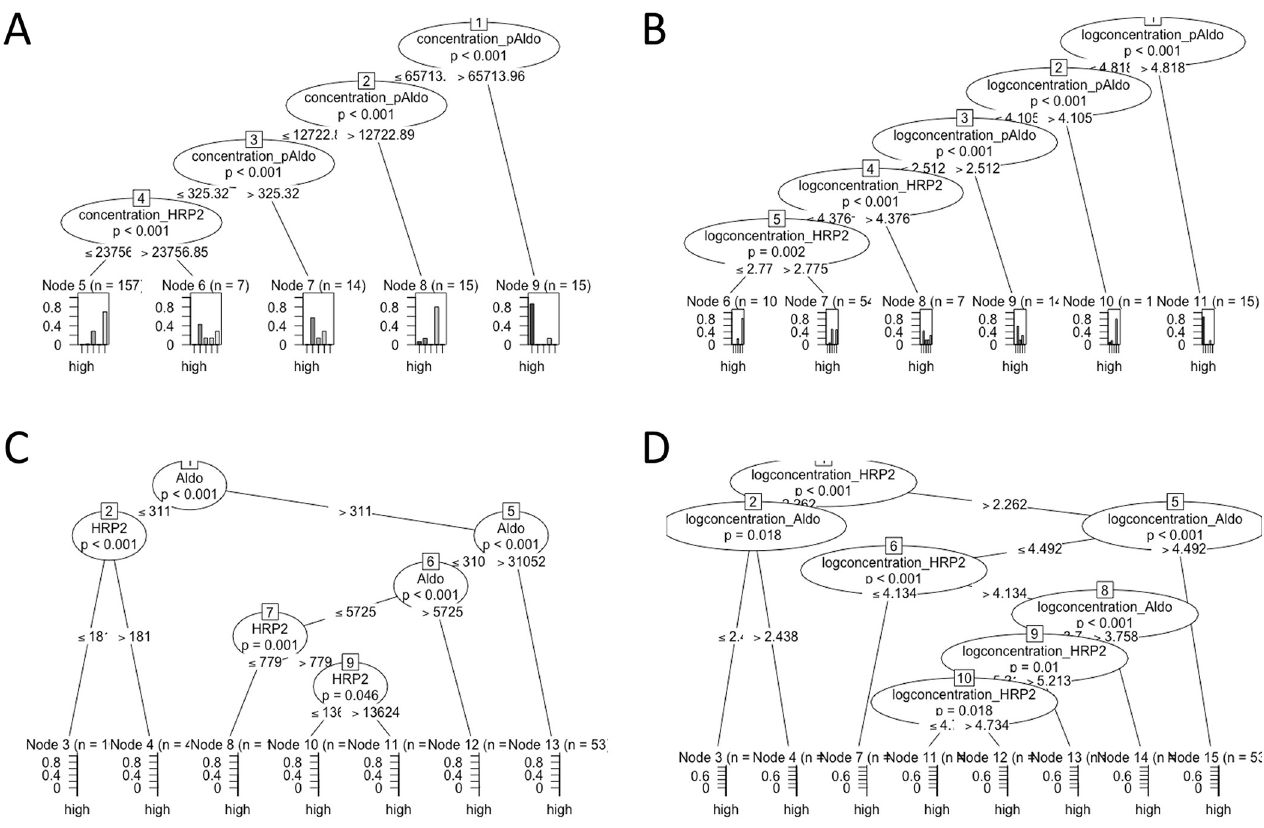
Fig 3. Conditional inference trees using HRP2, pLDH, and pAldolase antigen concentration and log concentration for malaria infection level classification. Infection level categories: None = 0 parasites/ μ L; Very low = > 0–20; Low = > 20–200; Mid = > 200–2,000; High = > 2,000. A) Angola (sen- qPCR). B) Angola (sen-qPCR), log. C) Haiti (PET-PCR). D) Haiti (PET), log. Y-axes at base of trees indicate probability of correct classification on a scale of 0.0 to 1.0. https://doi.org/10.1371/journal.pone.0275096.g003 When log-transforming the antigen data, additional prediction nodes were generated with the Angolan sen-qPCR predicting two nodes with the first of pAldolase at 325.1 pg/mL and second of HRP2 concentration at 595.7 pg/mL (Fig 2B). The log-transformed Haitian antigen data also provided two nodes for infection presence/absence, the first at HRP2 concentration of 182.8 pg/mL, and the second at a higher HRP2 concentration of 779.8 pg/mL (Fig 2D). PCR infection status was predicted with accuracies ranging from 73–96%, while infection level was predicted with accuracies ranging from 59–66% (Table 1). Table 1. Percent accuracies for malaria infection status prediction.